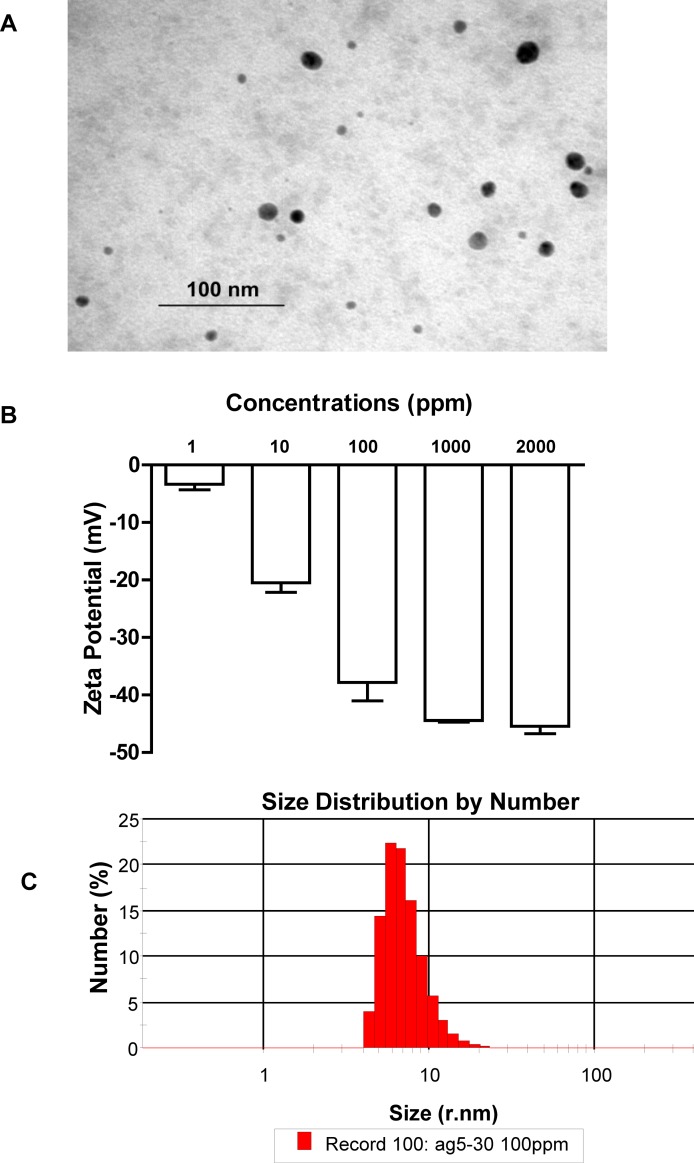
TEM image of AgNPs suspended in 5% sucrose solution.